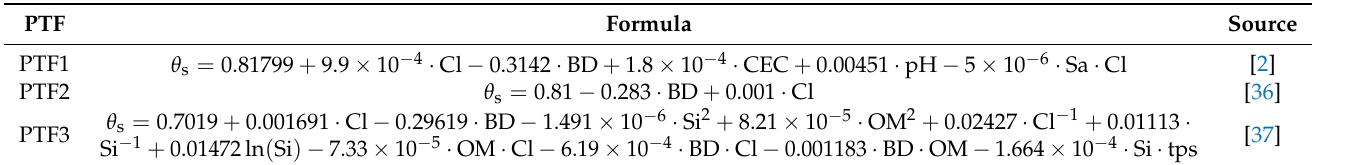
Table 1. PTFs for θ s estimation.